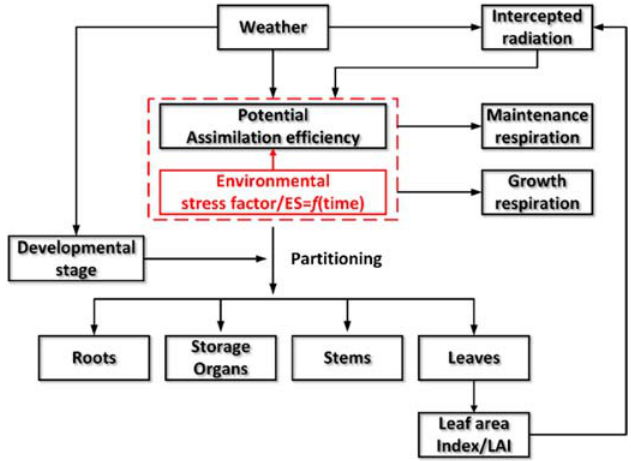
Figure 1. Simplified diagram of the structure of the modified model (WOFOST-ES) under general environmental stress.